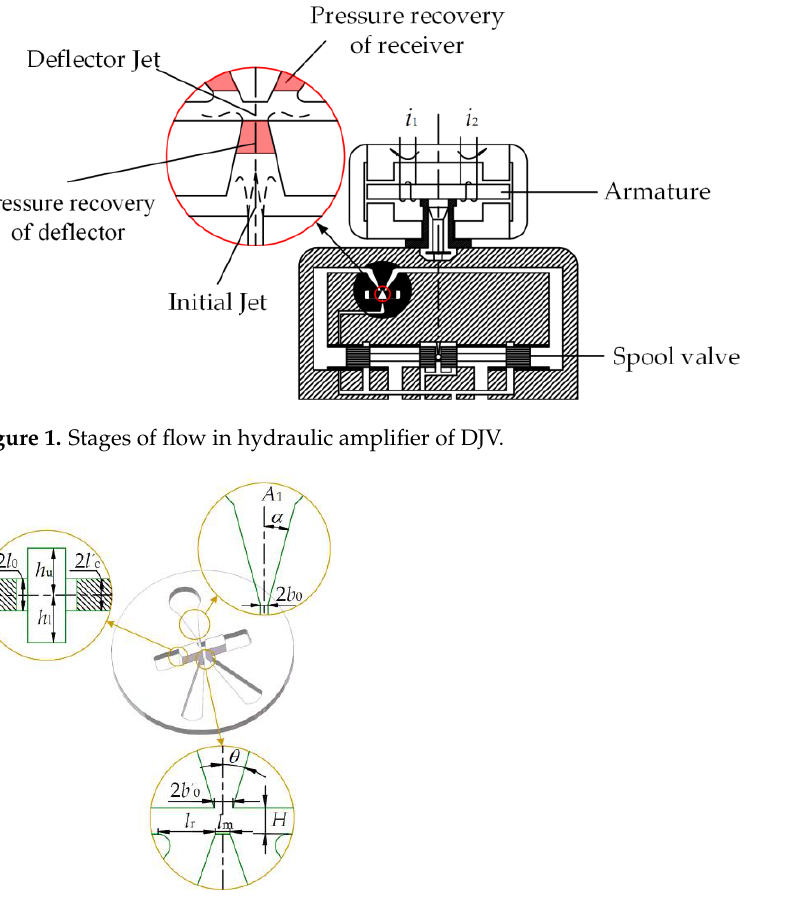
Figure 2. Parameters of deflector jet mechanism for three-dimensional description.